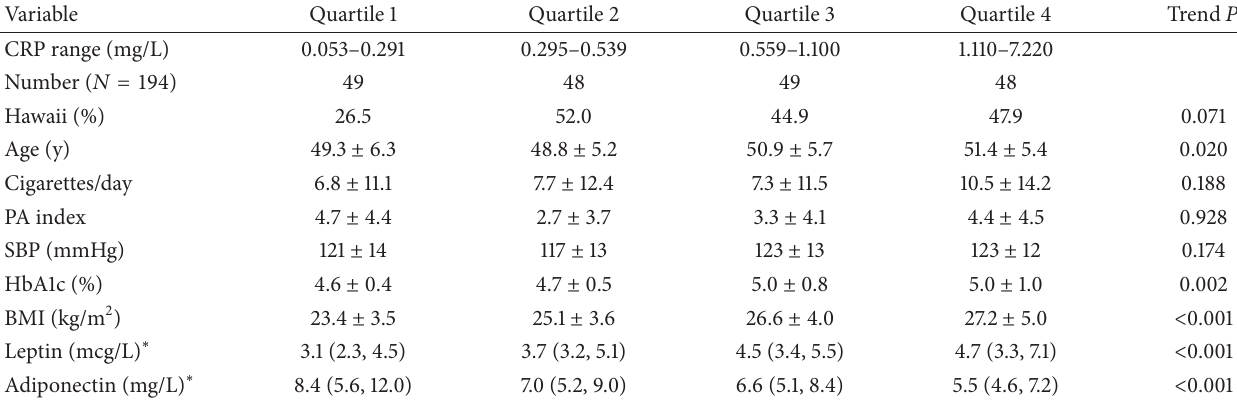
Table 1: BMI, SBP, serum leptin, adiponectin, and other characteristics by quartile of serum CRP in men.